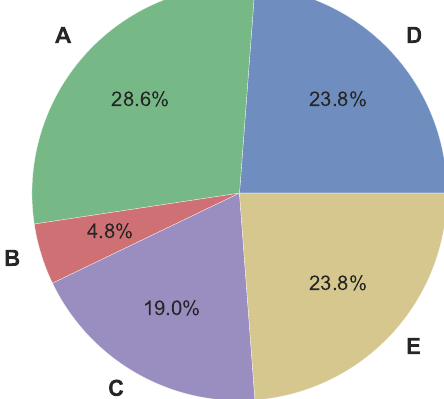
Figure 4. Representation of works divided by categories or application area, namely: A—crop and climate protection and diagnosis; B—nutrition and fertilization of crops; C—crop irrigation; D—soil management, planting, growing and harvesting crops; and, E—production management, machinery and equipment.